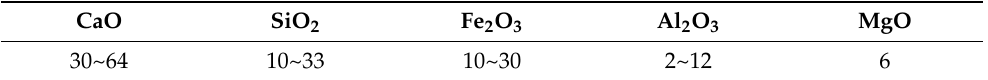
Figure 8. Effect of ω (Al 2 O 3 ) on the liquid-phase region of CaO–SiO 2 –Fe 2 O 3 –Al 2 O 3 –6%MgO slag sys- tem at 1450 °C.